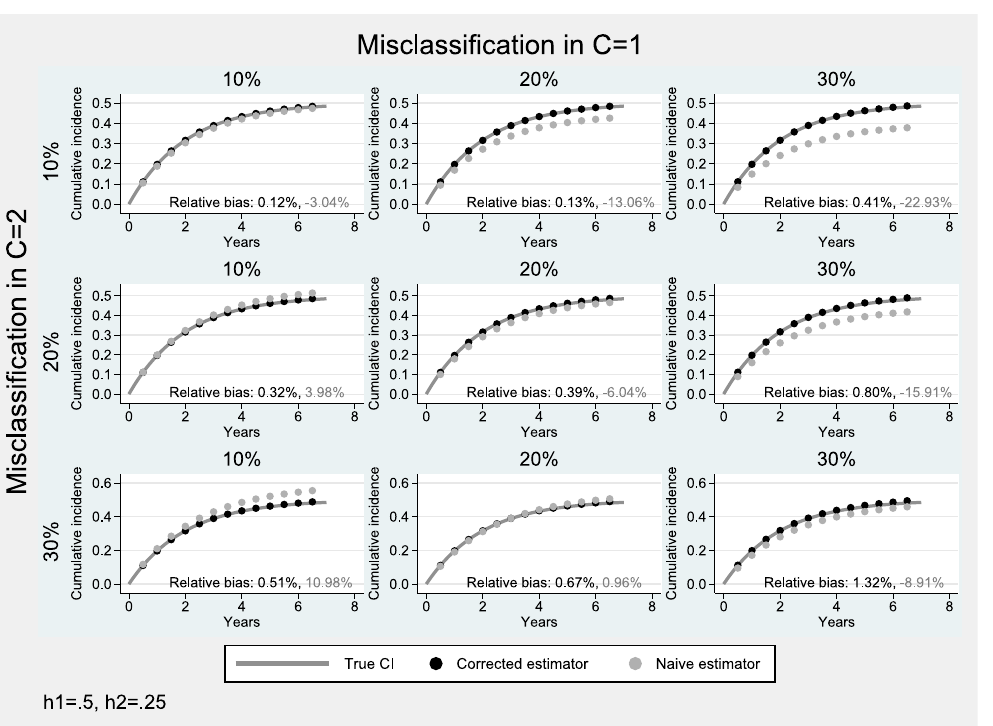
Fig 4. Simulation results for the case of bidirectional misclassification: Hazard parameter for the primary endpoint greater than that of the competing event ( h 1 = 0.5, h 2 = 0.25). Solid lines correspond to the true cumulative incidence whereas dotted lines to the estimates from the non-parametric Aalen-Johansen estimator for the primary